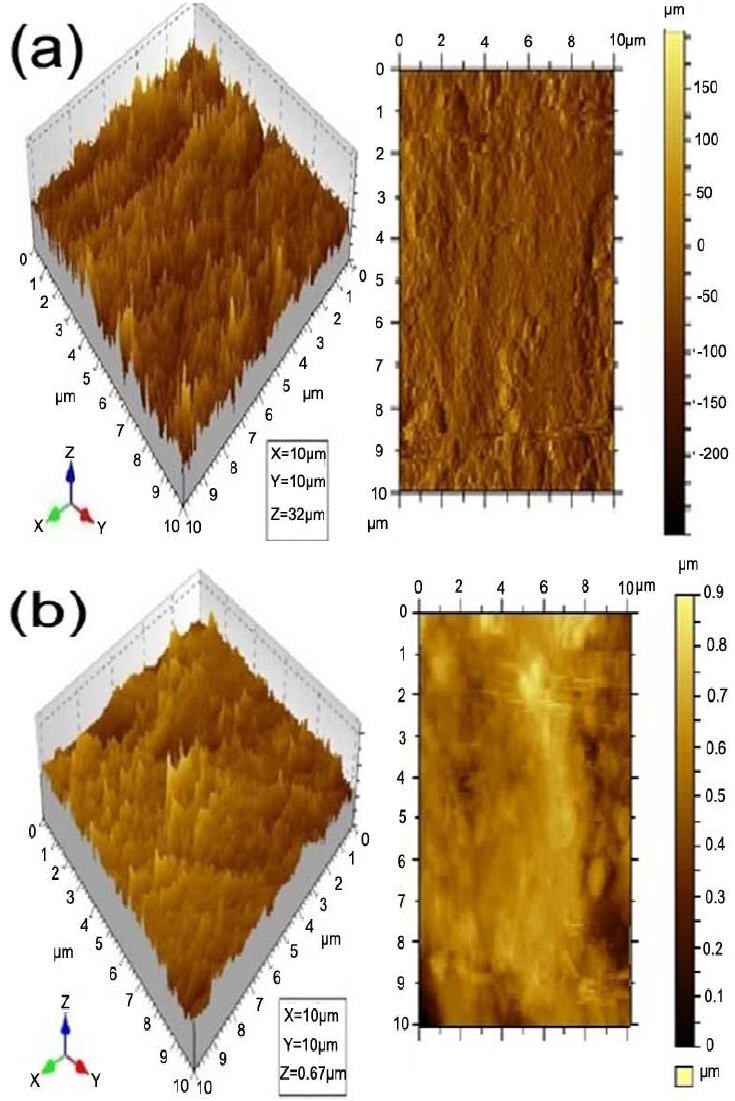
Figure 13. AFM image of the eroded surface of the substrate and coatings at low and high erodent discharge rates. ( a ) Velocity: 30 m/s angle: 60° distance: 55 mm erodent discharge: 500 g/min; ( b ) discharge rates. ( a ) Velocity: 30 m/s angle: 60 ◦ distance: 55 mm erodent discharge: 500 g/min; velocity: 30 m/s angle: 60° distance: 55 mm erodent discharge: 2500 g/min. ( b ) velocity: 30 m/s angle: 60 ◦ distance: 55 mm erodent discharge: 2500